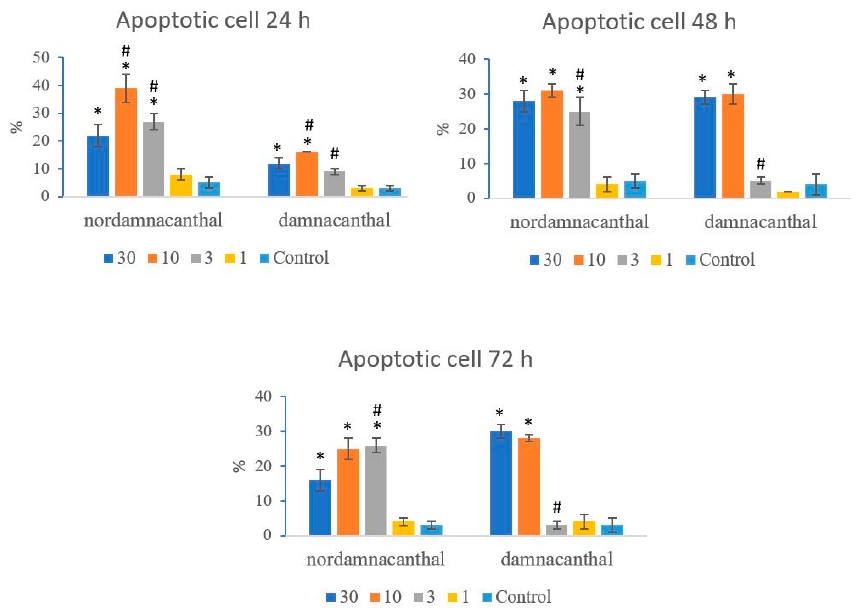
Figure 13. The percentages of apoptotic CEM-SS cells treated with different concentrations of nordamnacanthal and damnacanthal at 24, 48, and 72 h. Control cultures were not treated with nordamnacanthal or damnacanthal. Each data point represents the mean ± SD. * Significant difference of p < 0.05 within the same anthraquinone group vs. its respective control. # Significant difference of p < 0.05 between nordamnacanthal and damnacanthal of the same